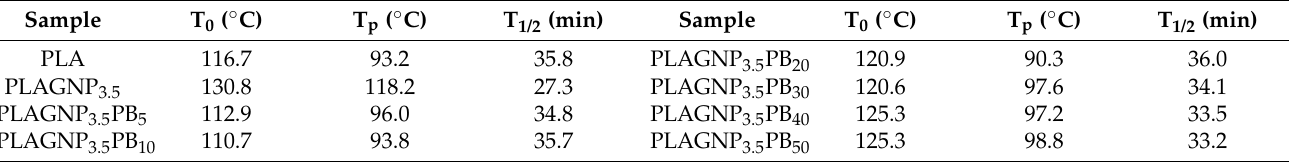
Table 1. Comparison table of the crystallization process of PLAGNP 3.5 PB y composite.